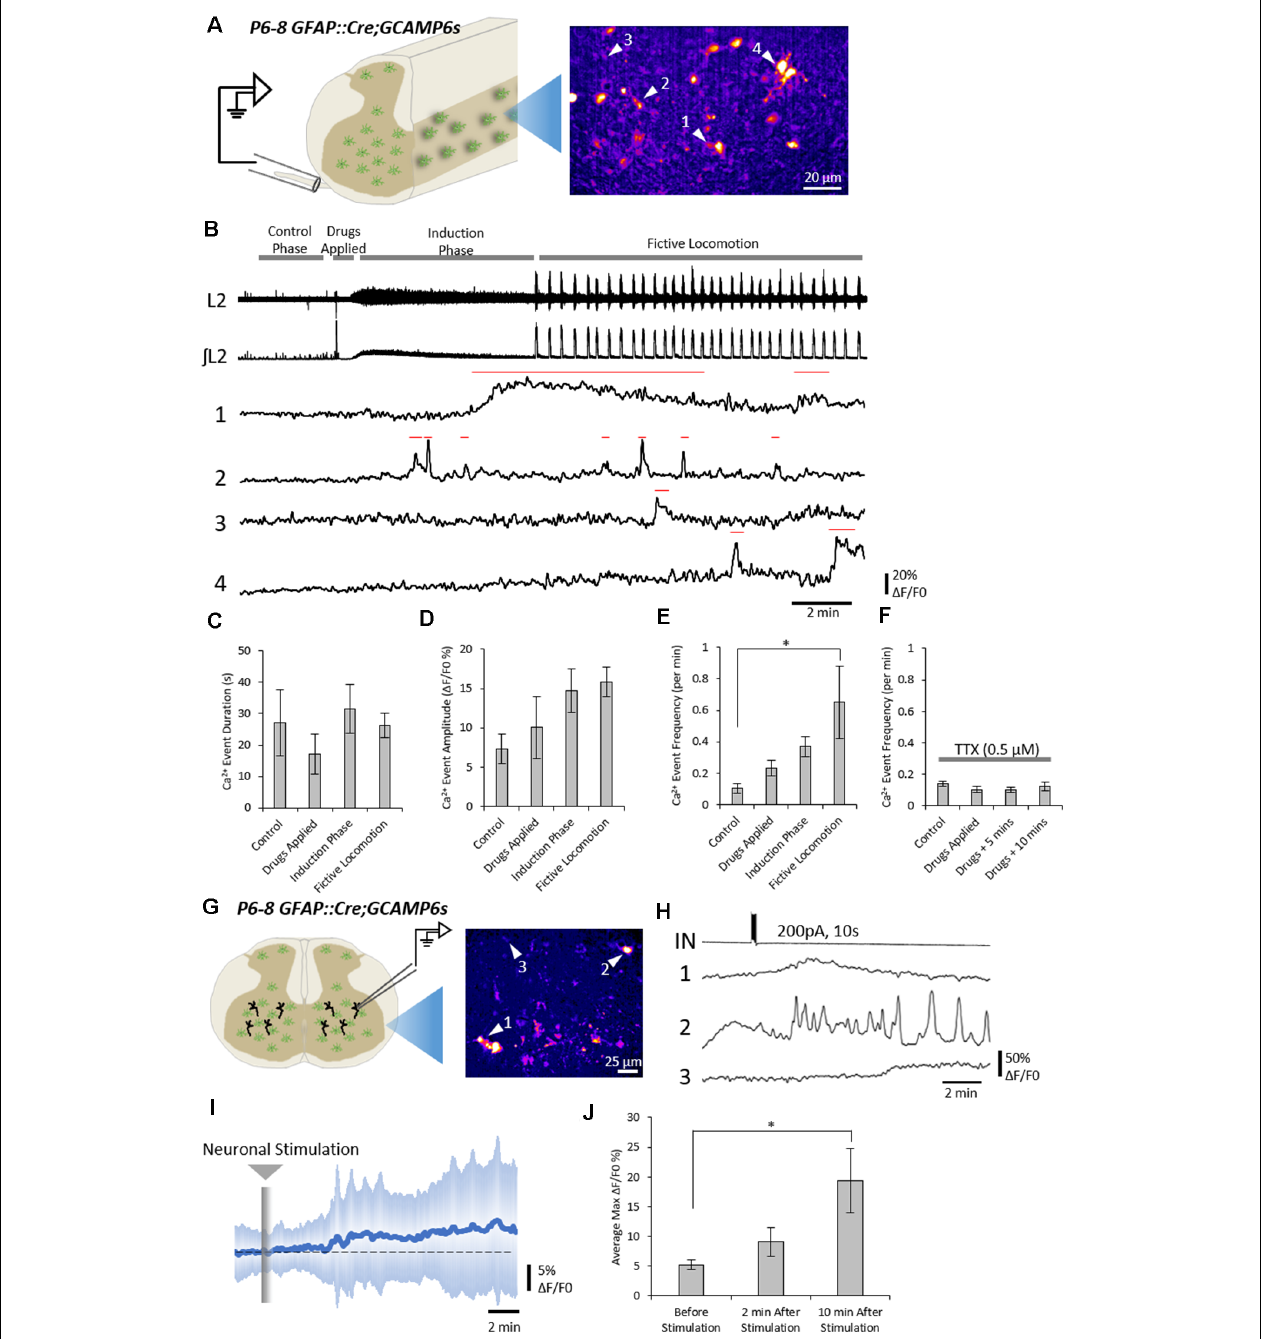
FIGURE 1 | Neuronal activity evokes Ca 2+ responses in spinal astrocytes. (A) Schematic of hemisected spinal cord preparations in which simultaneous ventral root recording and Ca 2+ imaging of astrocytic activity were performed. (B) Example data from one experiment showing ventral root activity from baseline to the induction of fictive locomotion and Ca 2+ imaging traces from four astrocytes (denoted in panel A ). Red lines above traces indicate the Ca 2+ events detected for analysis. (C) Bar chart showing the duration of astrocytic Ca 2+ transients during different phases of the experiment. (D) Bar chart showing the intensity of astrocytic Ca 2+ transients during different phases of the experiment. (E) Bar chart showing the frequency of astrocytic Ca 2+ transients during different phases of the experiment. (F) Bar chart showing the frequency of astrocytic Ca 2+ transients during different phases of the experiment when the hemisected cord was perfused with tetrodotoxin (TTX). (G) Schematic of a spinal cord slice with a simultaneous whole-cell patch-clamp recording from a ventral horn interneuron and Ca 2+ imaging of astrocytic activity. (H) Example data from one experiment showing the activation of a spinal cord interneuron (IN), and the Ca 2+ transients from three astrocytes (denoted in panel G ). (I) Averaged Ca 2+ imaging trace from 52 astrocytes from eight separate experiments in response to neuronal stimulation. (J) Bar chart showing the maximum intensity of Ca 2+ transients in astrocytes before and after neuronal stimulation. ∗ p < 0.05.